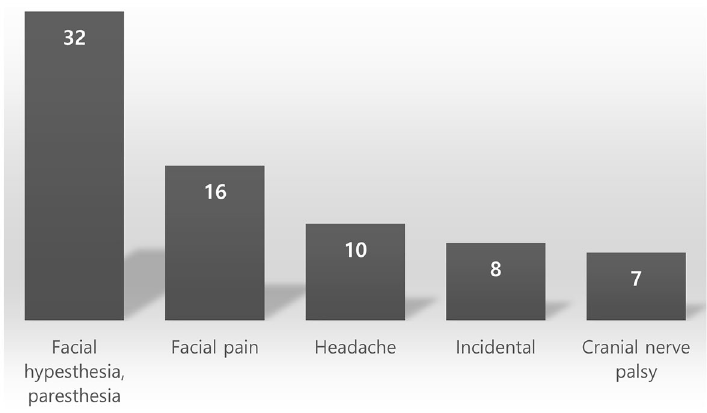
Figure 3. Symptom distribution in patients with trigeminal schwannomas.